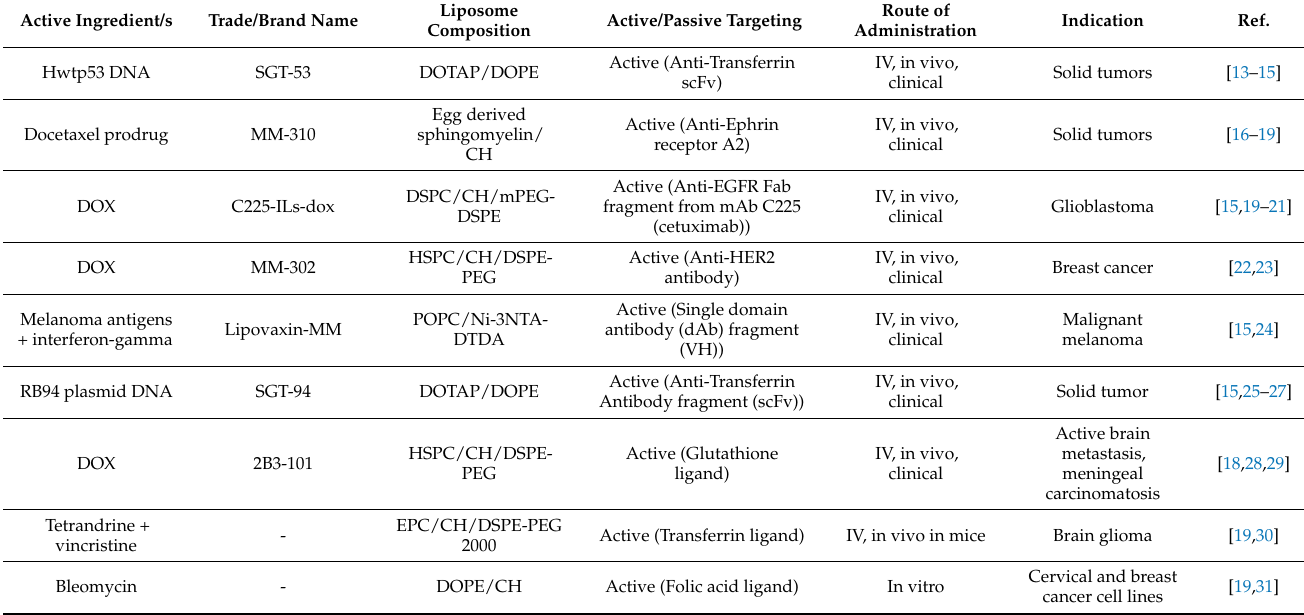
Table 1. Some recent examples of anticancer liposomal drug delivery systems and their targeting mechanisms. Active